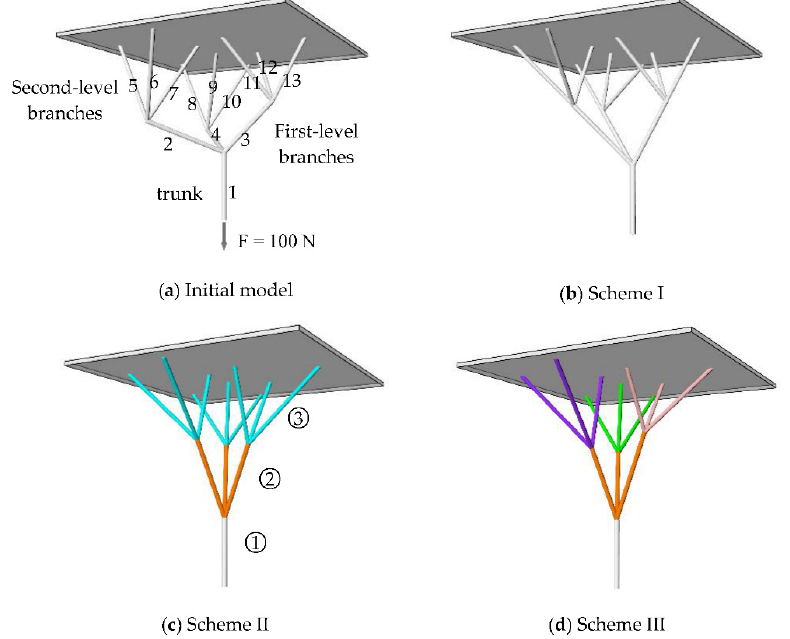
Figure 1. Shape schemes of different element clusters. ( a ) initial flexible model; ( b ) form-found shape of traditional DR method; ( c , d ) form-found shapes of element-clustered method.